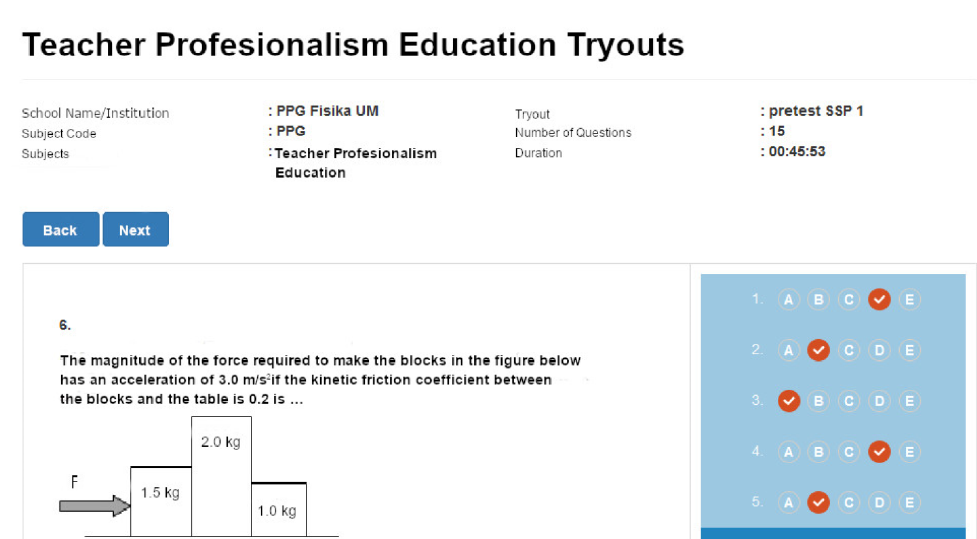
Figure 2.Students Test Interface in the Tryout application